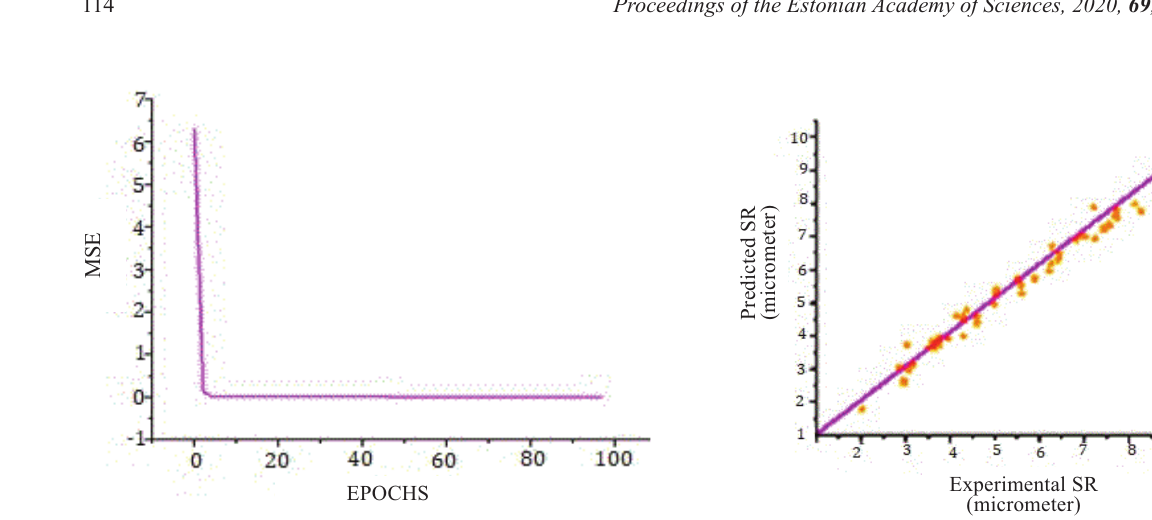
Fig. 2. Deviation of MSE in training with number of emphases for 3­6­1 neural system.